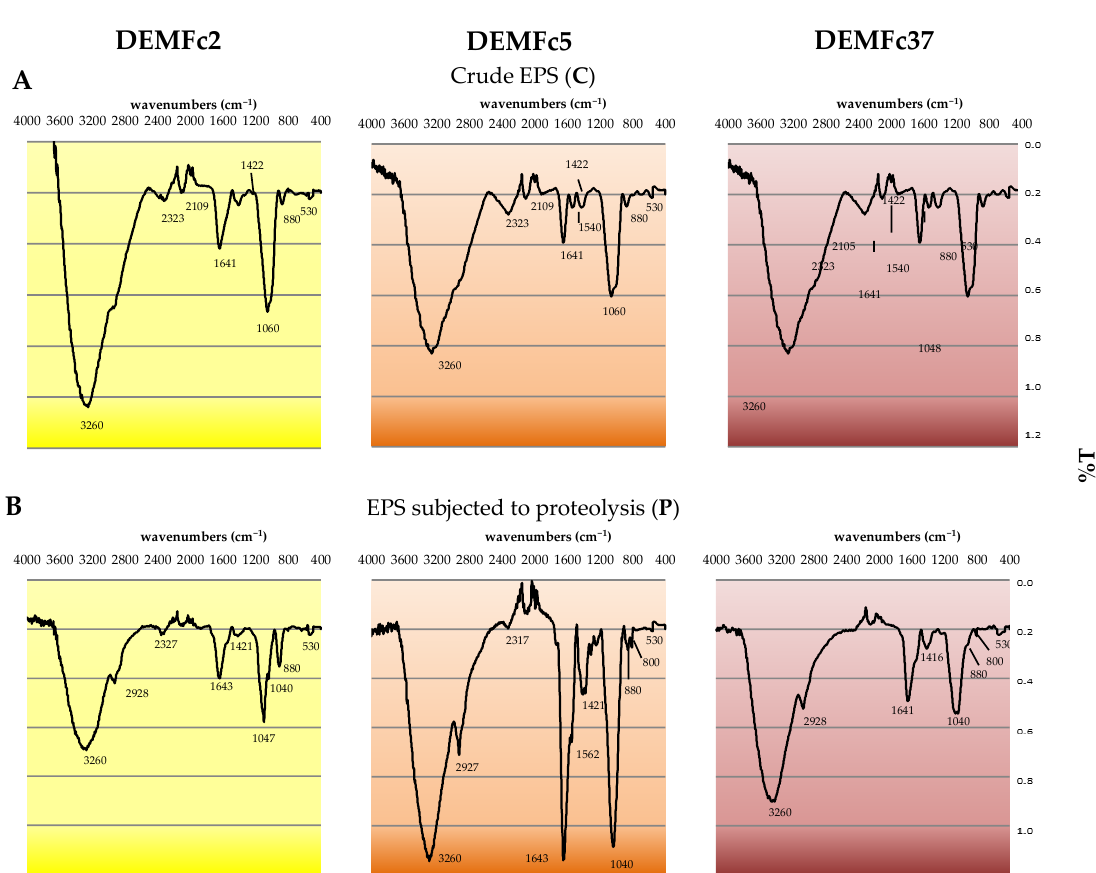
Figure 13. Infrared (FTIR) spectra of A. crude EPS (C) and B. proteolysed EPS (P) obtained from cultures of three F. culmorum strains: DEMFc2, DEMFc5, and DEMFc37.